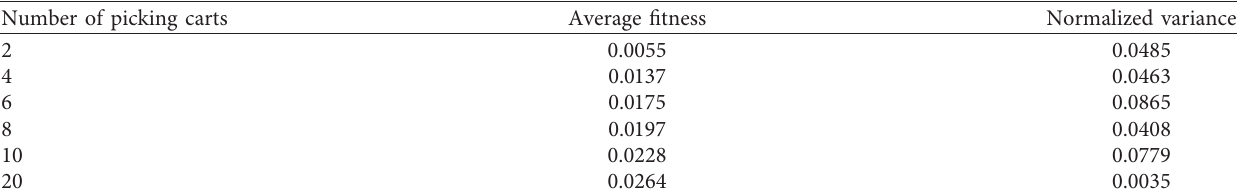
Table 4: Fixed multivehicle